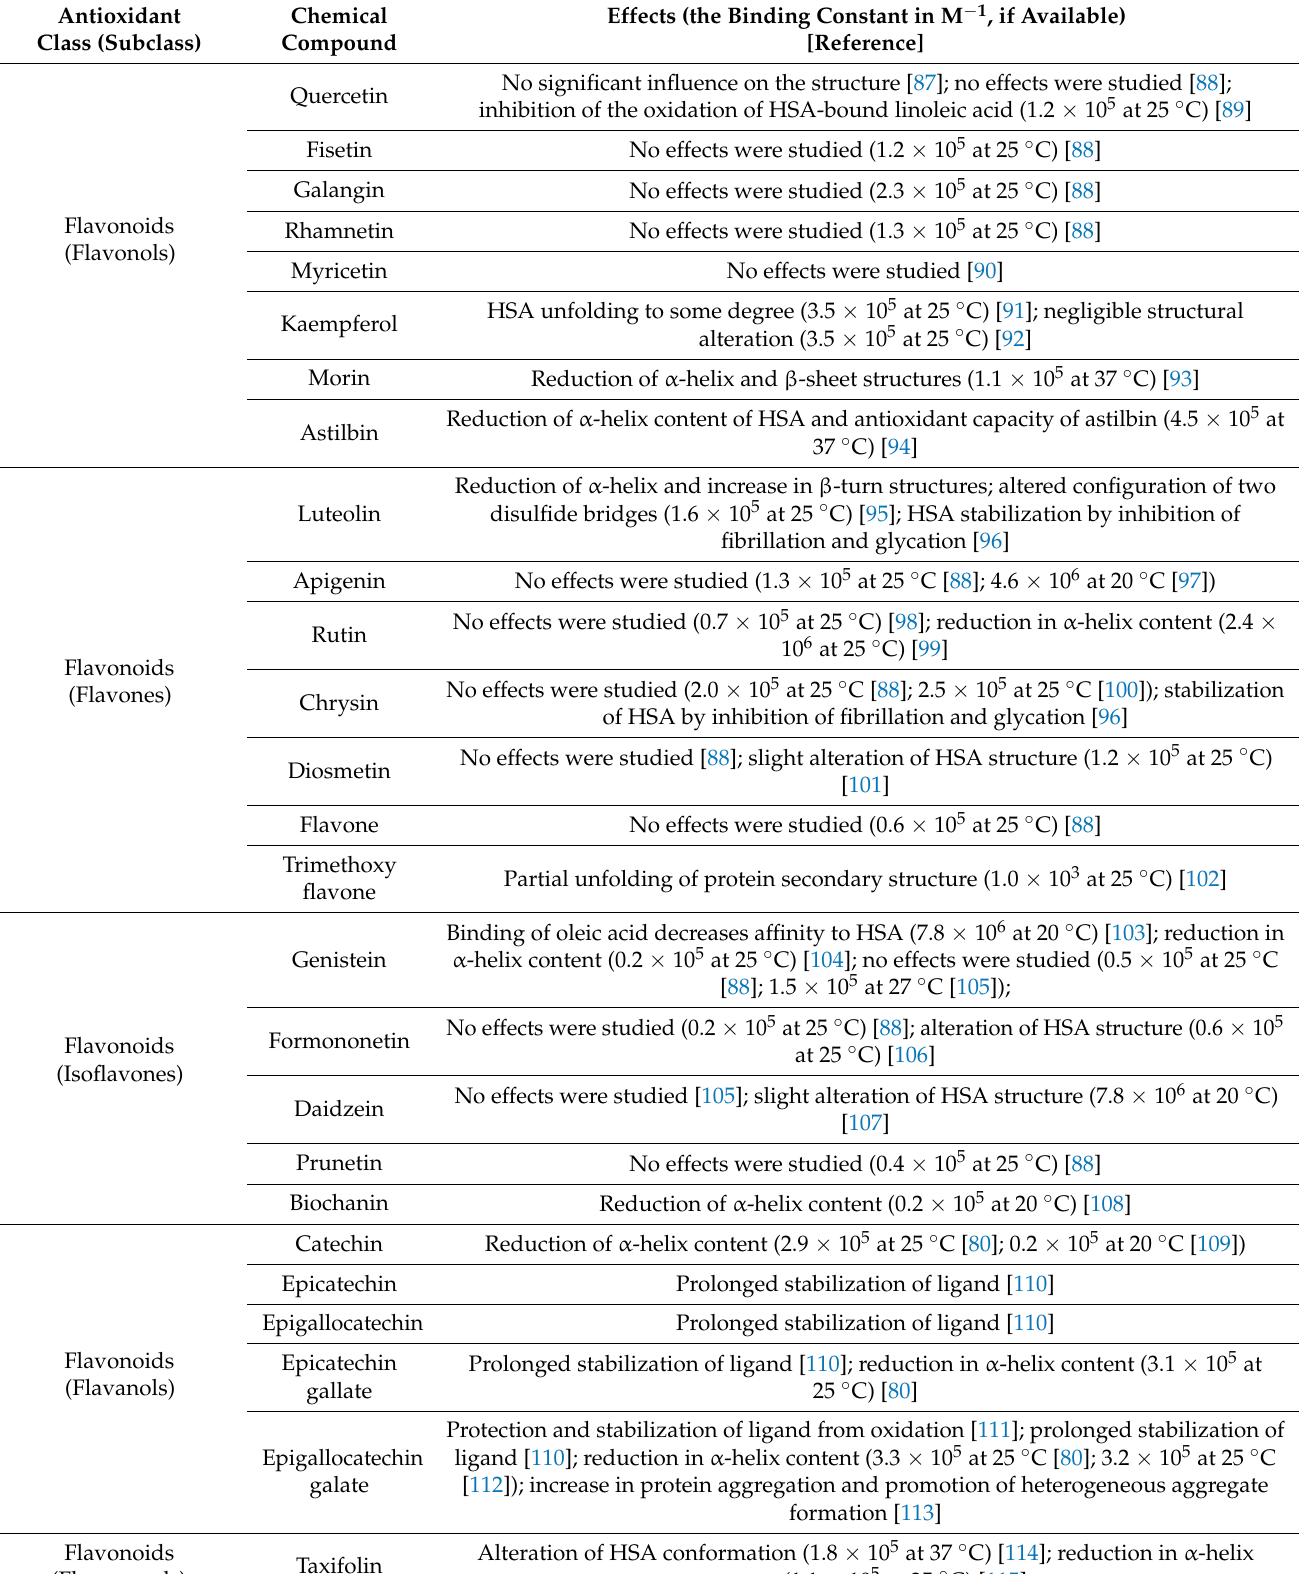
Table 1. Known interactions between food antioxidants and human